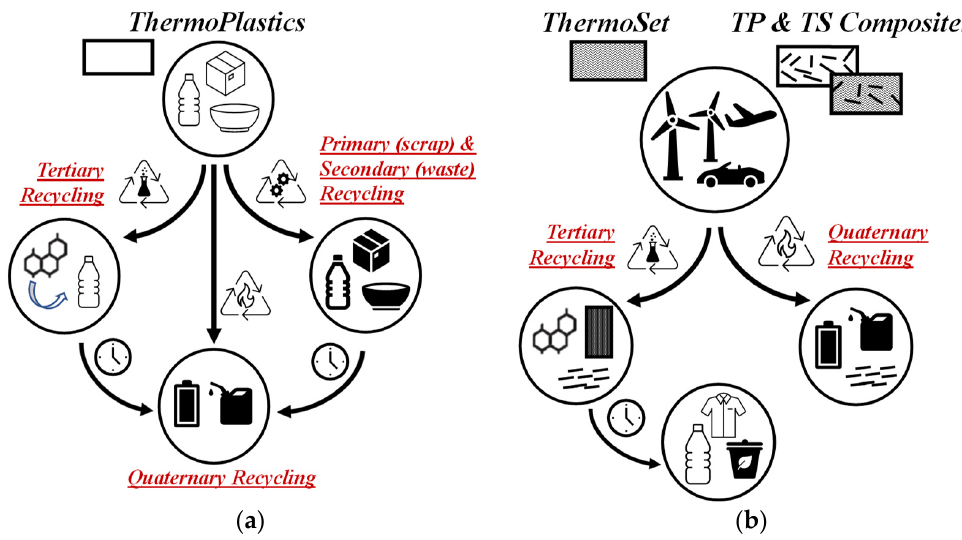
Figure 2. Schematic diagram to summarize current status for recycling of ( a ) thermoplastics and ( b ) thermoset and the composites, highlighting more appropriated and applicable at large industrial scale recycling strategies